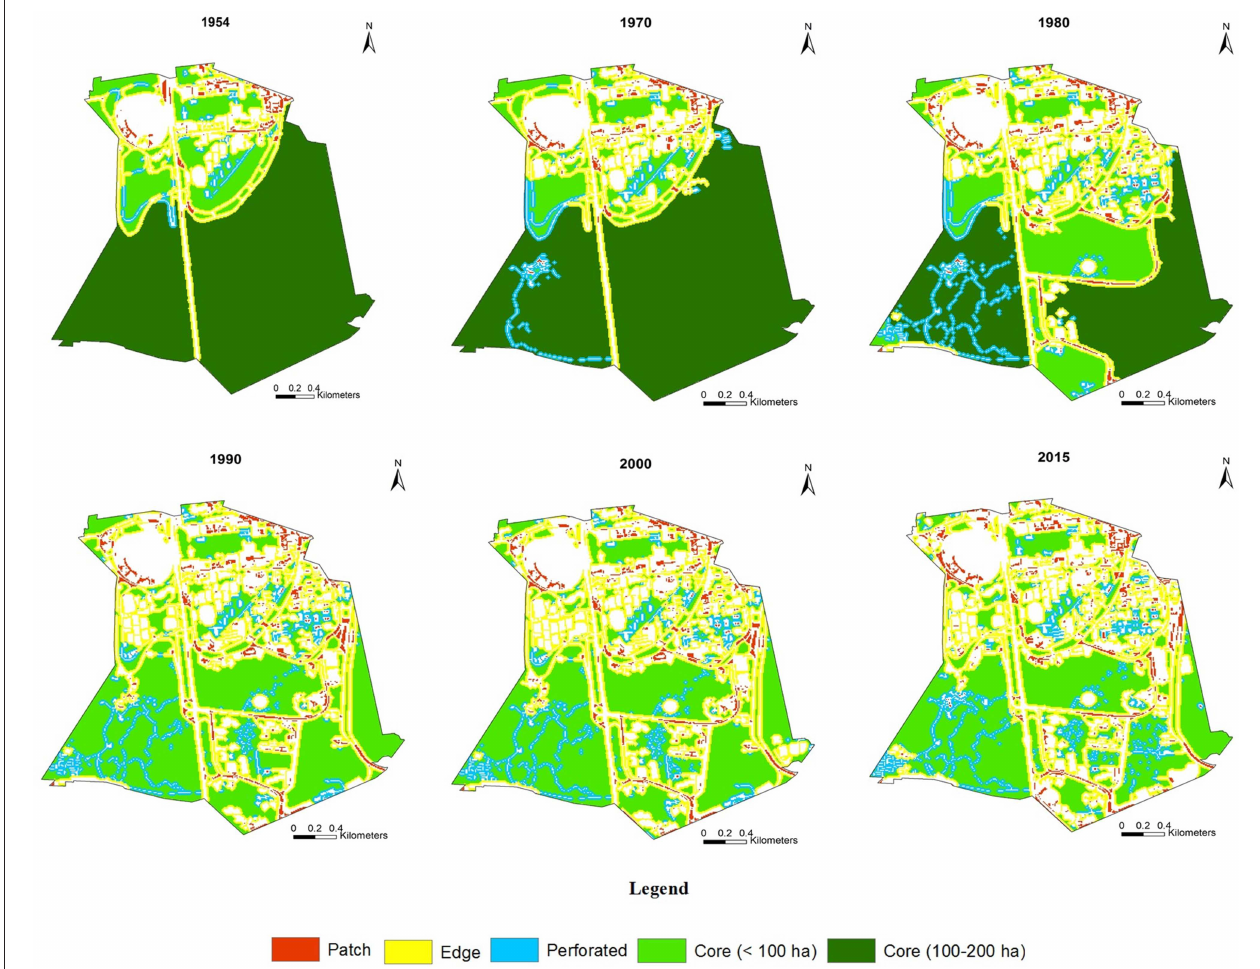
FIGURE 3 | Fragmentation maps of the UNAM campus between 1954 to 2015. For information about the analyses used to generate each category see